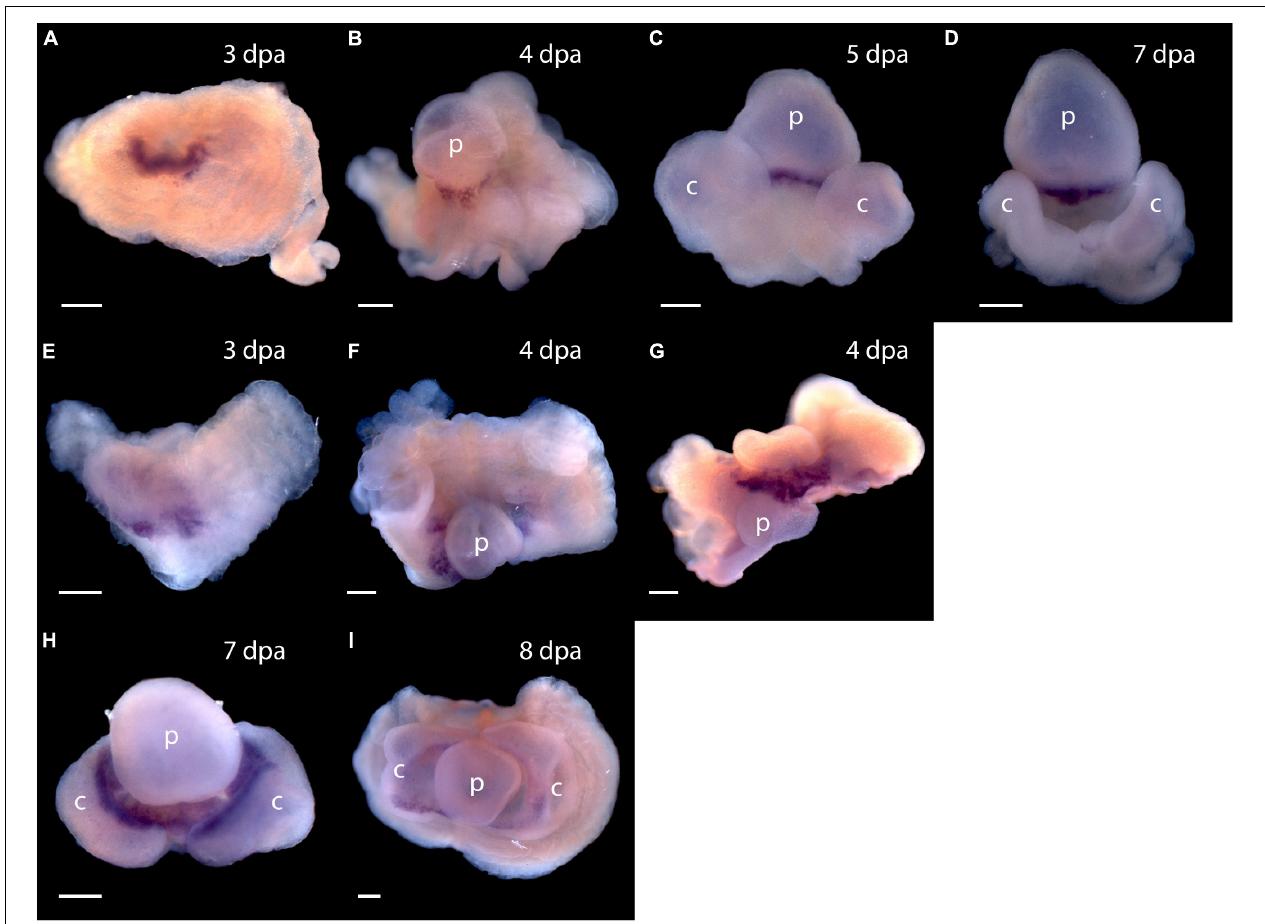
FIGURE 7 | Expression of organizer genes Pf-Gsc and Pf-FoxA . (A–D) Whole mount in situ hybridization of Pf-Gsc at (A) 3 days post-amputation (dpa), (B) 4 dpa, (C) 5 dpa, and (D) 7 dpa of regeneration, respectively. Pf-Gs c marks the ventral base of the blastema, which become the base of the proboscis in all samples stained. (E–I) Whole mount in situ hybridization of Pf-FoxA at 3–8 dpa of regeneration. (E) Pf-FoxA is expressed at the ventral margin of the blastema, lateral to the Pf-Gsc signal, which becomes the edge of collar at 3 dpa. (F) At 4 dpa, dorsal view (G) at 4 dpa, (H) at 7 dpa, (I) at 8 dpa, ventral view. Ventral is facing the viewer in all figures except (F,G) in which the proboscis is facing the viewer. p, nascent proboscis; c, nascent collar. Dorsal is up in all panels except panel (G) . Scale bars = 0.25